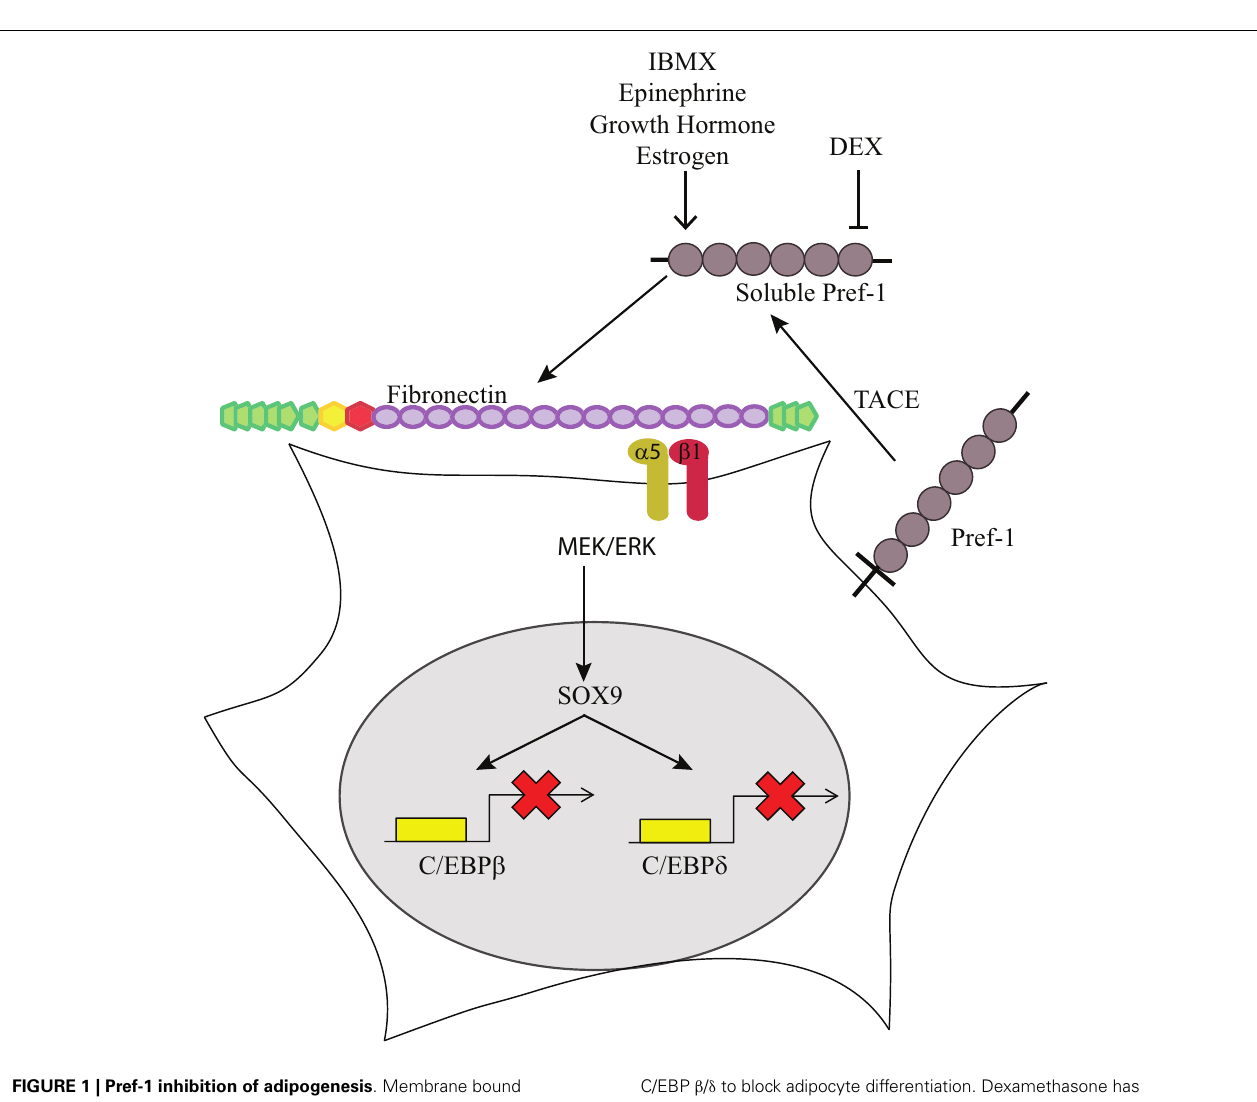
FIGURE 1 | Pref-1 inhibition of adipogenesis . Membrane bound Pref-1 is cleaved byTACE to generate a 50kDa soluble factor. Pref-1 interacts with fibronectin and via integrin α 5 β 1 activates MEK/ERK, which increases Sox9, which then binds to the promoter regions of